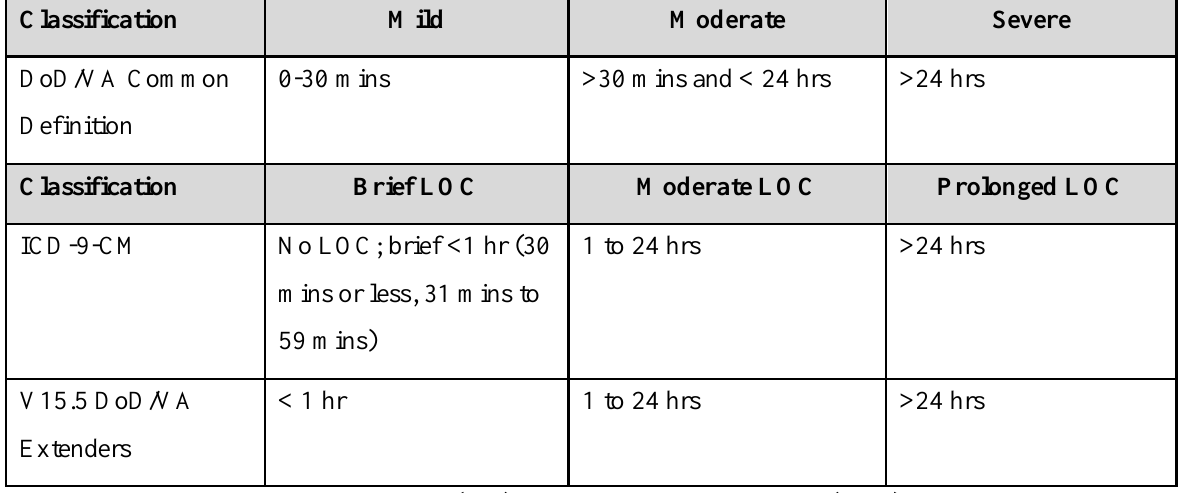
Table 4. Stratification of Severity by Length of time of Loss of